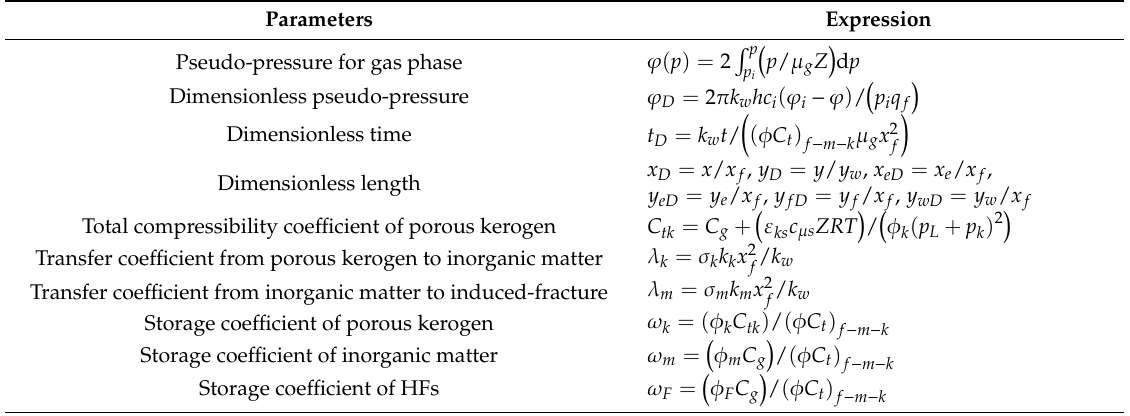
Table A1. Basic parameters used in